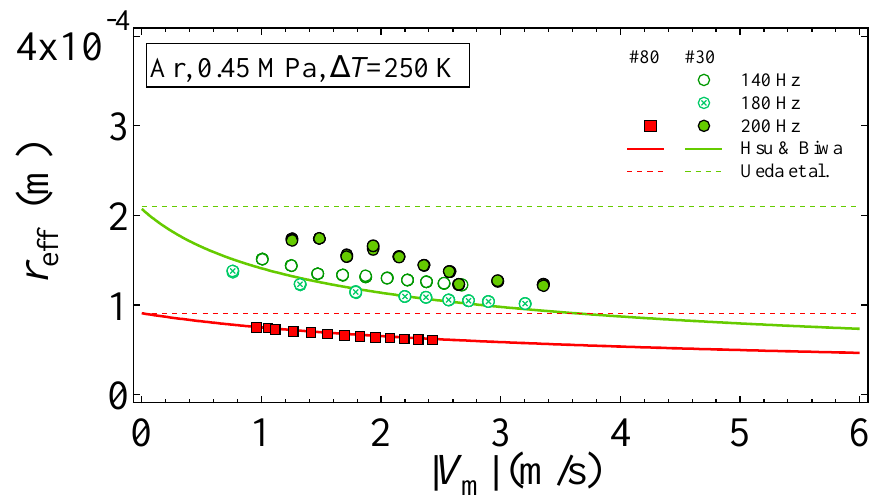
V m Figure 6. Relation between r eff and . Symbols represent the experimental effective radius of | | the stacked-screen regenerator of #30 and #80 meshs. Curves stand for Equation (15) with thermal properties of the gas determined from a temperature averaged in T R and T H . Horizontal dashed lines represents the effective radius r 0 of Ueda et al.